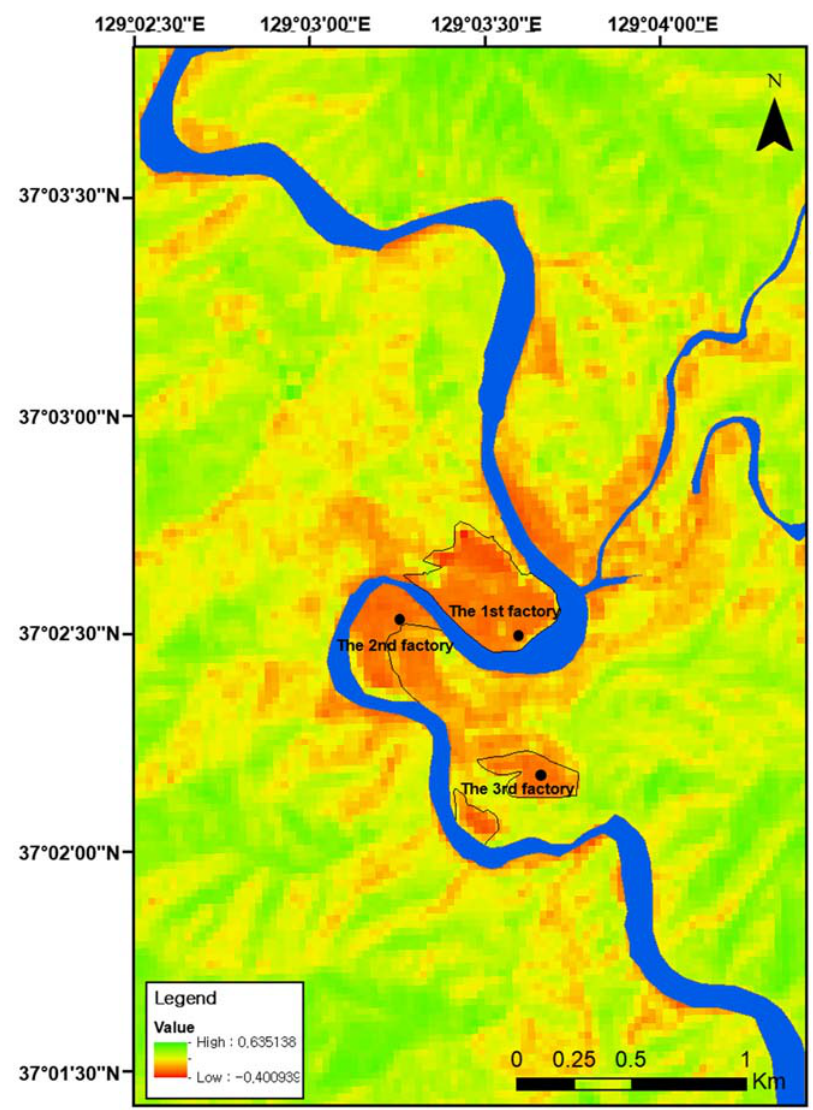
Figure 3. Spatial distribution of NDVI in the study area. Vegetation damage identified from the satellite image interpretation depended on the distance from the smelter and topography. The damage appeared was severer in sites closer to the smelter and decreased farther away (Figure 4). The degree of damage was also dominated by topographic conditions, and therefore damage was restricted within the first ridge from the pollution source, little damage thus appearing on the opposite slope or beyond the first ridge from the smelter (Figure 4).